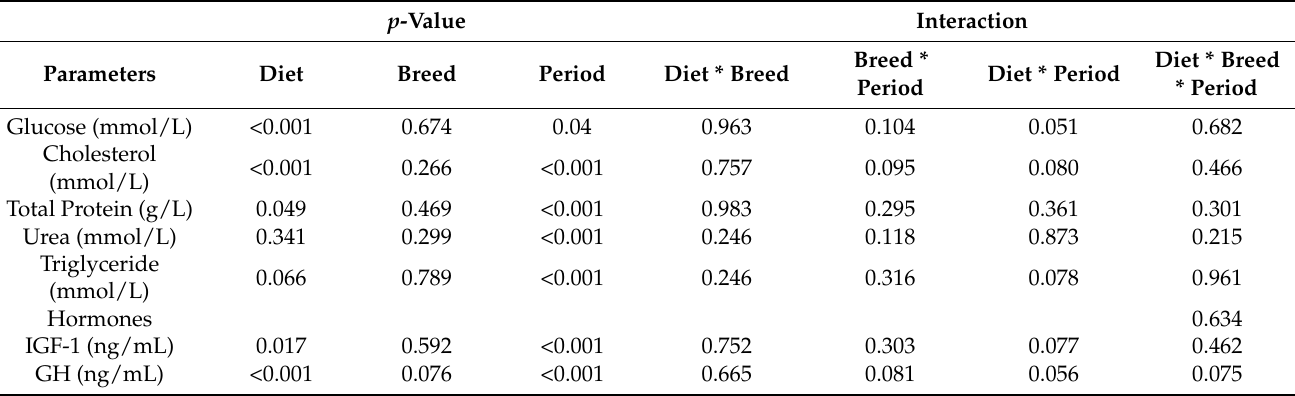
Table 5. The significant values for the effect of different diet on serum biochemical and hormonal profiles for both buffalo. p -Value Interaction Parameters Breed Period Diet * Breed